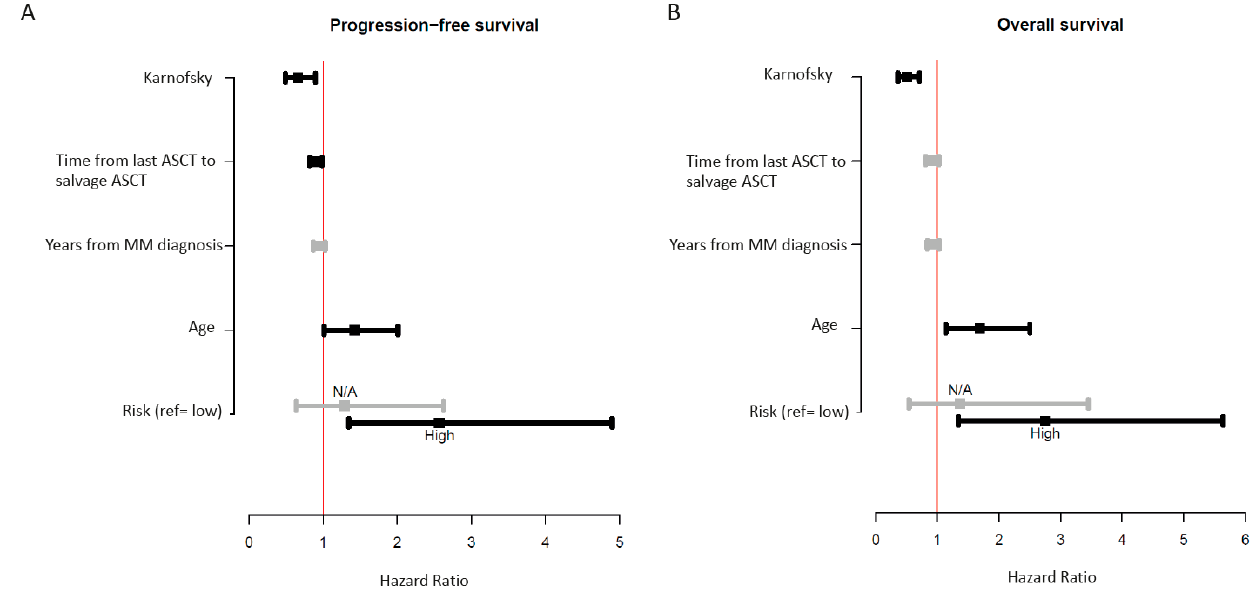
Figure 2. Univariate analysis of clinical markers associated with improved or worse PFS ( A ) and OS ( B ).